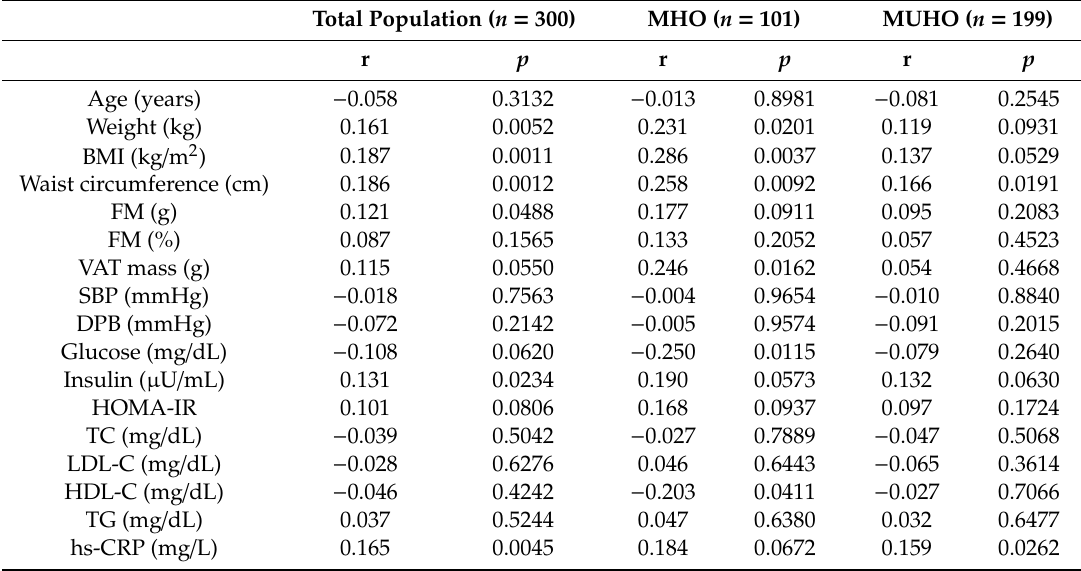
Table 3. Correlations between lactoferrin levels and selected variables.